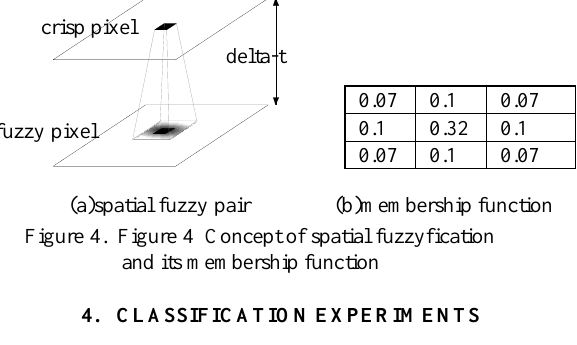
Figure 4. Figure 4 Concept of spatial fuzzyfication and its membership function